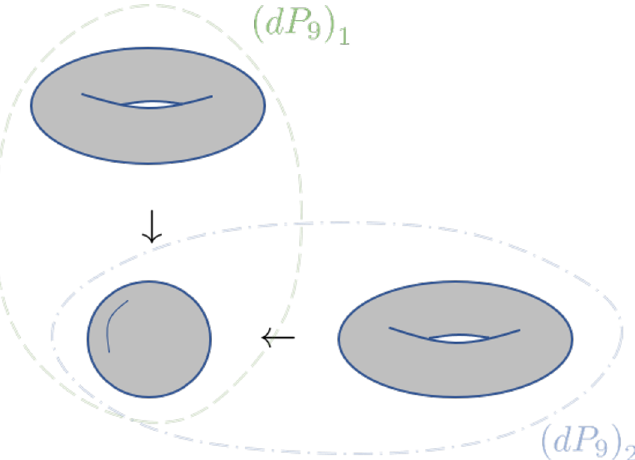
Figure 13 . Illustration of the Schoen manifold as the fibre product of two del Pezzo surfaces dP 9 .